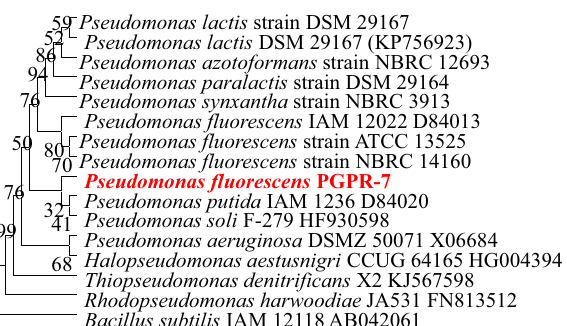
Figure 2. Neighbor-joined phylogenetic tree of Pseudomonas fluorescence PGPR-7. The tree was constructed based on 16S rRNA partial gene sequence and closely related phylogenetic species (type cultures) derived using the NCBI BLAST search tool. Sequences were aligned using Clustal W sequence alignment tool in MEGA 7.0 software. The GenBank accession numbers of isolates and closely related species are presented in brackets.